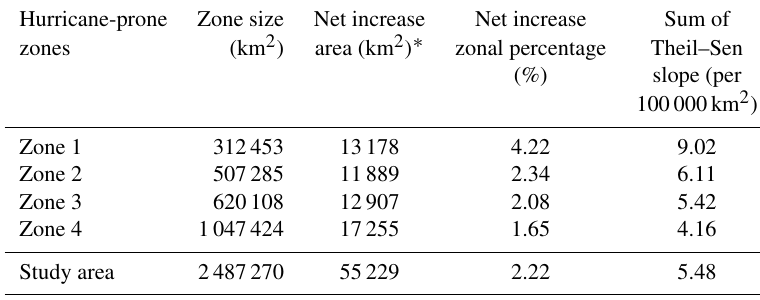
Table 3. Hurricane-prone zonal summary of the Mann–Kendall and Theil–Sen tests. Hurricane-prone Zone size Net increase Net